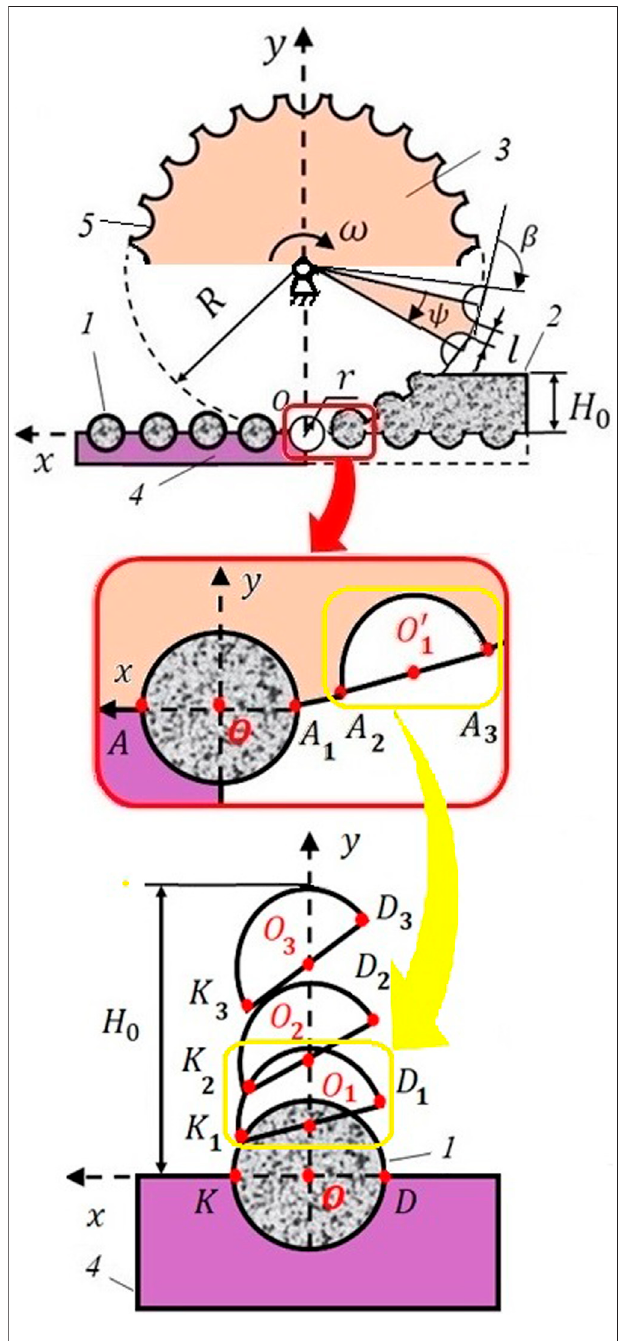
FIGURE 1 | Conditional scheme for the movement of the compacted fi nely dispersed medium in the gap of the shaft-conveyor belt: 1 — deaerated granule-sphere; 2 — solid fi nely dispersed material; 3 — shaft; 4 — conveyor belt; 5 — hemispherical shapes